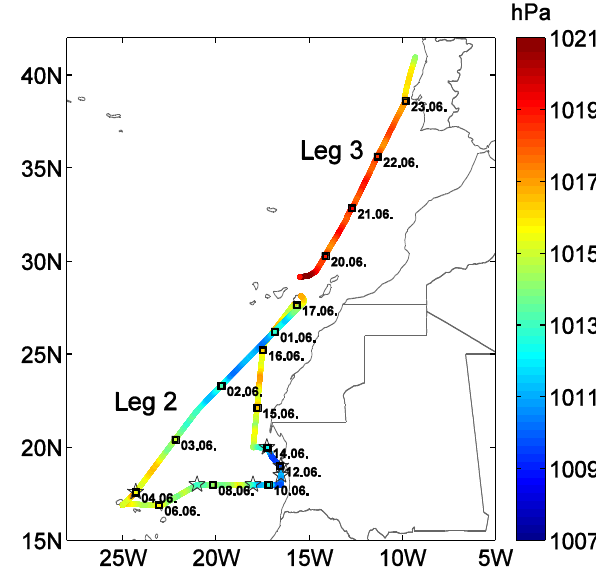
668 Fig. 2: 10 minute average measurements of air pressure [hPa]. The stars indicate position and 669 Fig. 2. 10min average measurements of air pressure [hPa]. The stars time of the diurnal stations. 670 indicate position and time of the diurnal 671